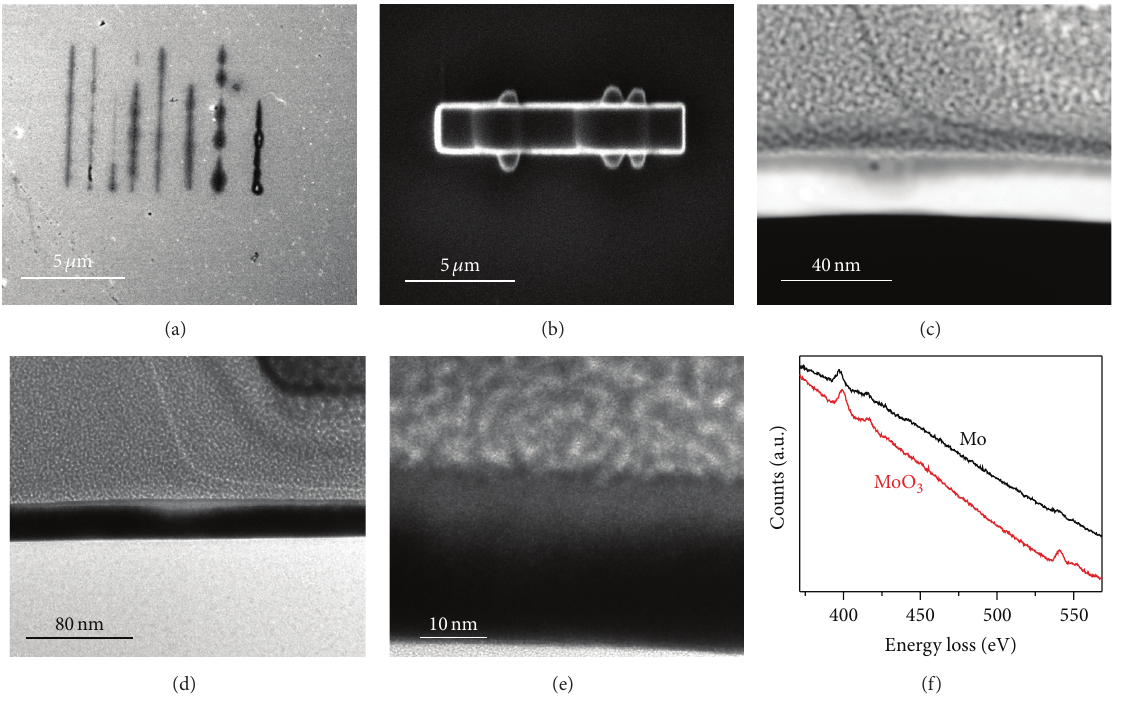
Figure 5: (Color online) (a) SEM image of Mo oxide lines. (b) SEM image of the same region as in (a) after Pt deposition of the protective layer on the top of three lines. (c) TEM image of the lamella showing a cross-section of the Mo oxide line. (d) HAADAF image in STEM mode of the same region showed in (c). (e) HAADAF high-resolution image of the Mo and Mo oxide. (f) EELS spectra containing both the O K core-loss (right) and the Mo M 3 core-loss (left) of Mo (black line) and MoO 3 (red